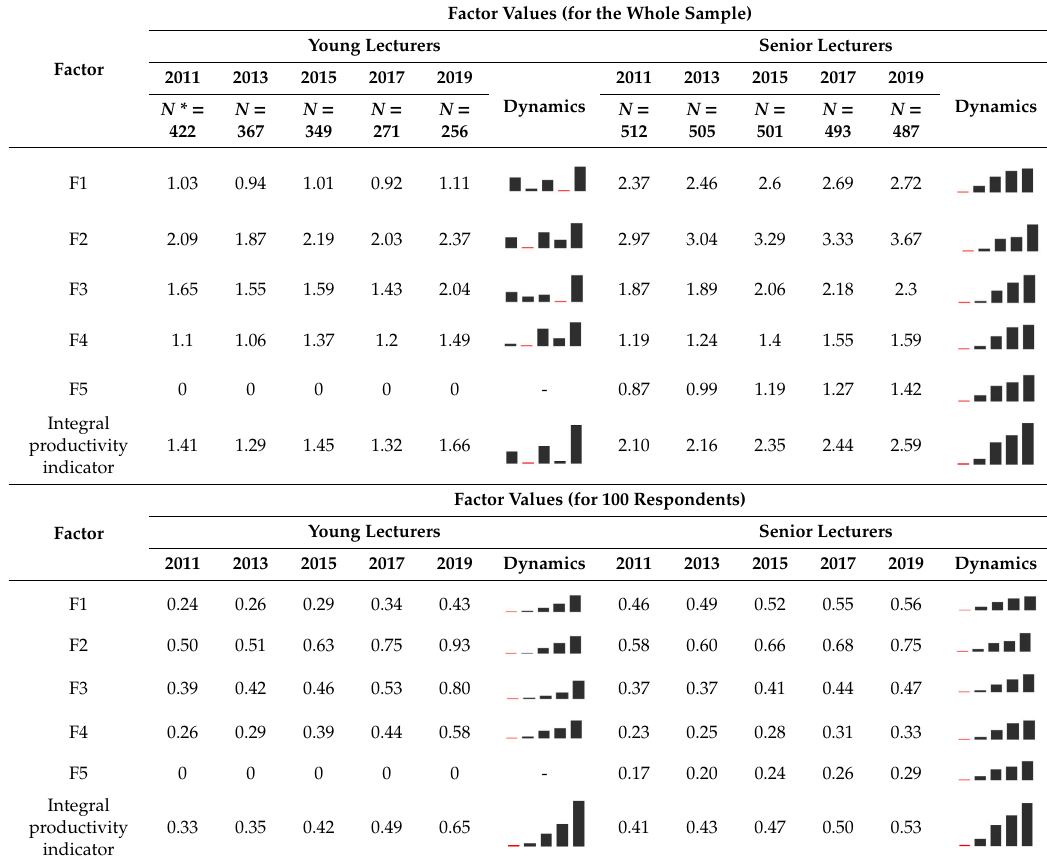
Table 6. Dynamics of the factor values and integral indicator of scientific activity output in Russian